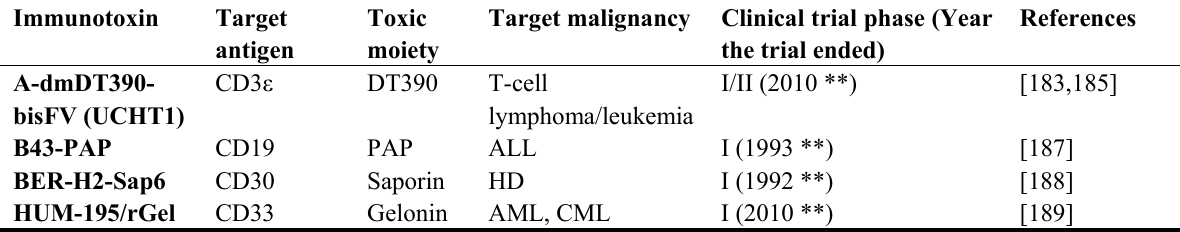
Table 5. Clinically evaluated/under evaluation immunotoxins against hematologic malignancies and solid